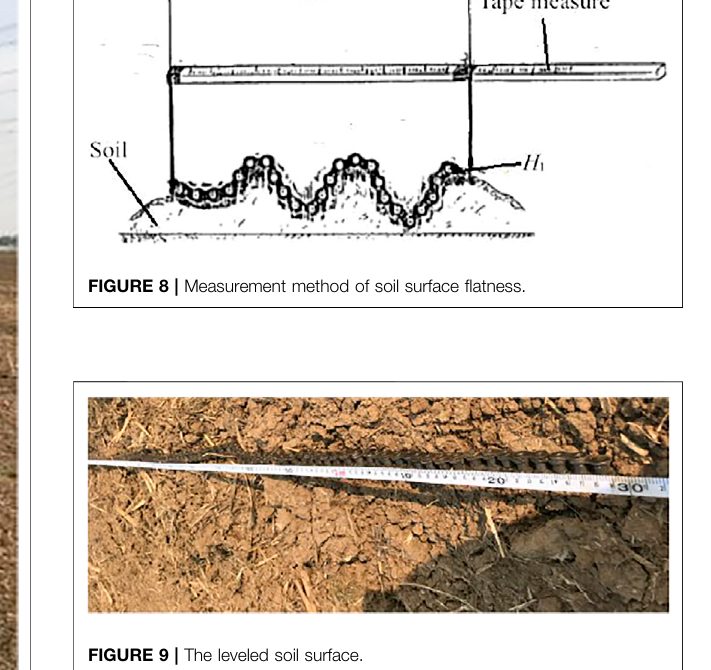
FIGURE 9 | The leveled soil